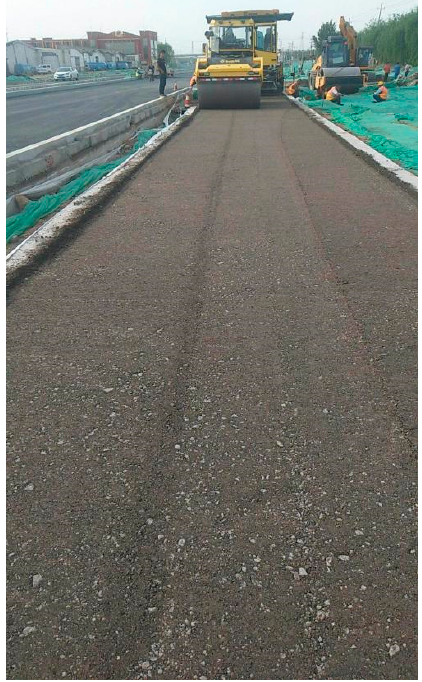
Figure 10. Photos of construction site.